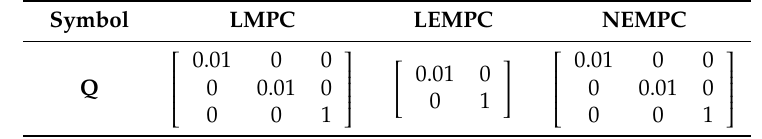
Table 9. Changed parameters in controllers.